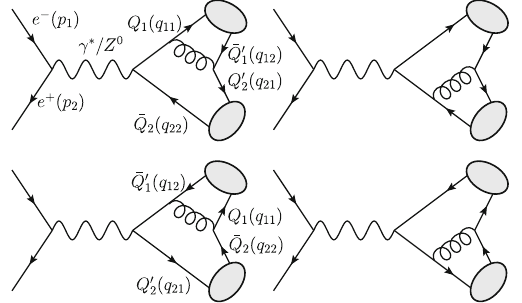
Fig. 1 Feynman diagrams for electron positron annihilation into dou- ble heavy quarkonia or B c ’s through the virtual photon and Z 0